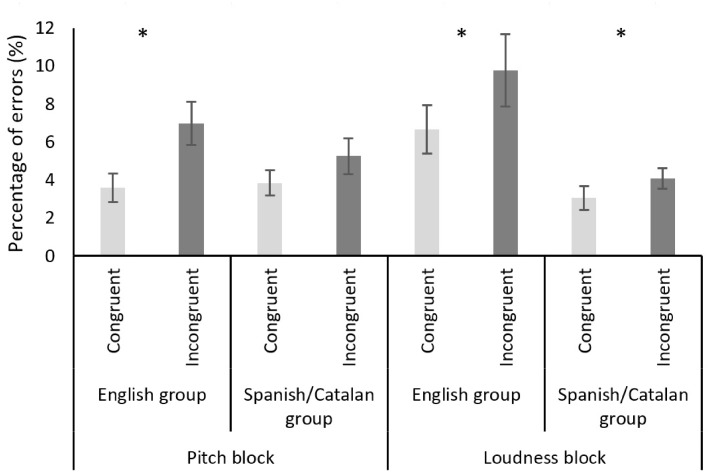
Mean percentage of errors in each block (pitch/loudness) and group (English/Spanish–Catalan) for the two different conditions (congruent/incongruent). Error bars indicate standard error of the mean. Single asterisk indicates a significant difference between conditions (p < .05).